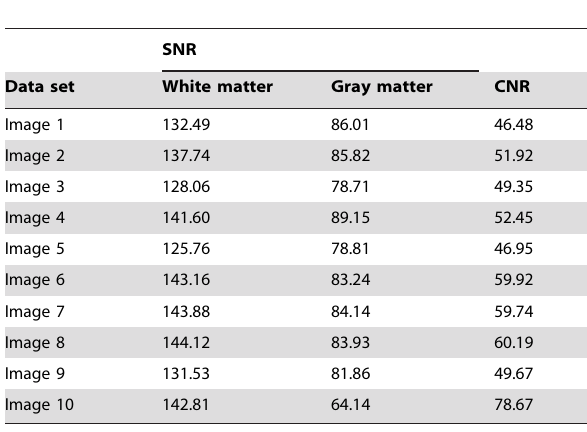
Table 3. Image quality parameters of the Single Subject data